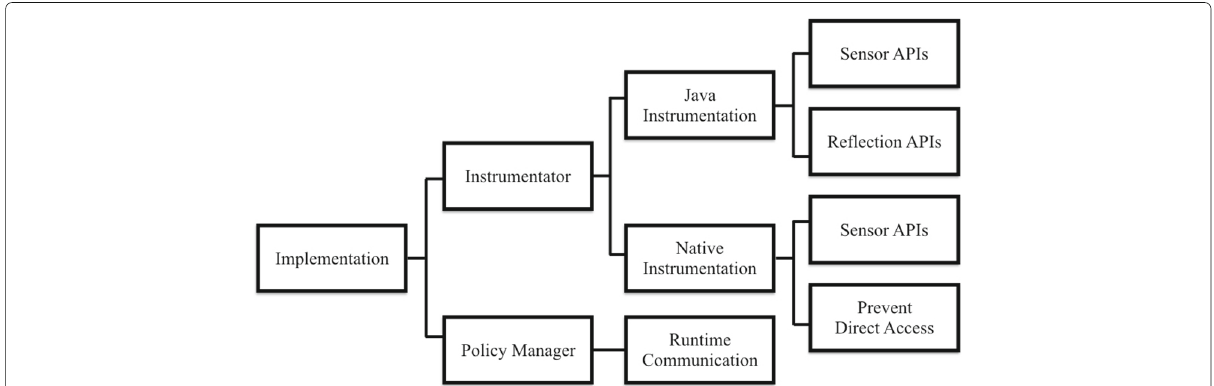
Fig. 1 Overview of Sensor Guardian’s implementation. The overview of Sensor Guardian’s implementation, including its Instrumentor and Policy Manager